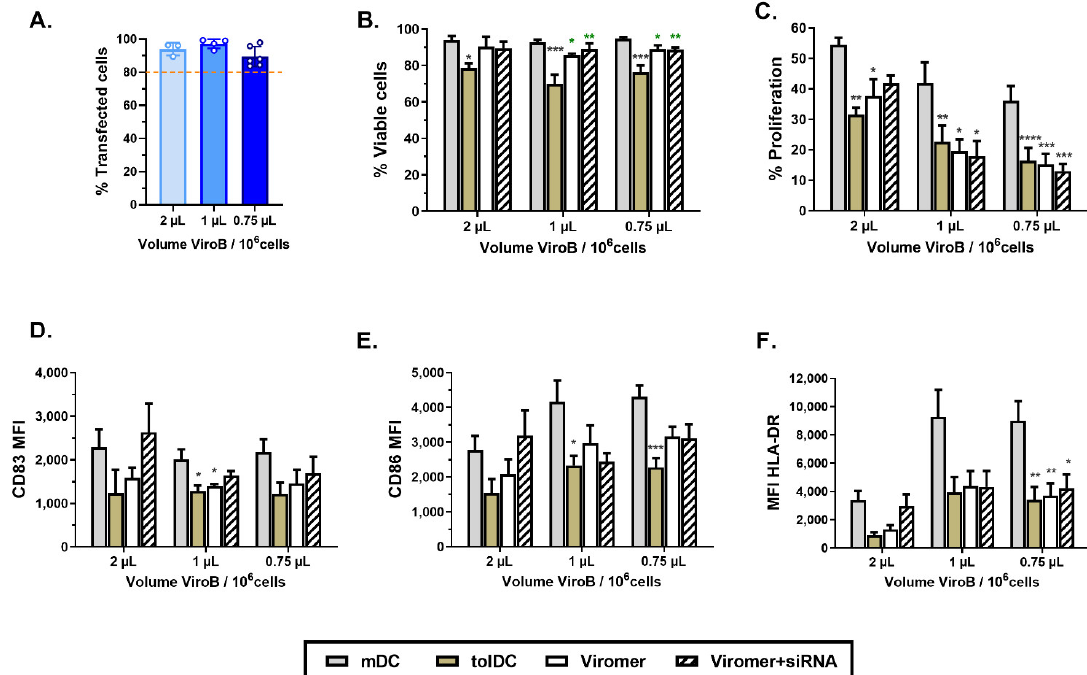
Figure 2. Transfection of monocytes on day 1 of differentiation using Viromer blue. Analysis of transfected (red-labeled or siGLO + cells) using 2 µ L, 1 µ L and 0.75 µ L of Viromer blue (ViroB) ( A ). Characterization of mDC, VitD3-tolDC and VitD3-tolDC obtained following ViroB or ViroB+non-targeting siRNA (ViroB+siRNA) treatment using 2 µ L, 1 µ L and 0.75 µ L of ViroB. Analysis of viability ( B ), functionality (ability to induce allogeneic PBMC proliferation using a ratio of DC/PBMC of 1/20) ( C ), and phenotype (mean fluorescence intensity, MFI, of CD83 ( D ), CD86 ( E ) and HLA-DR ( F ) molecules). Data shown as mean + SEM. For 2 µ L, n = 3; for 1 µ L, n = 5; and for 0.75 µ L, n = 8. Grey and green asterisks represent significance compared to mDC and VitD3-tolDC, respectively (* p < 0.05; ** p < 0.01; *** p < 0.001, **** p <